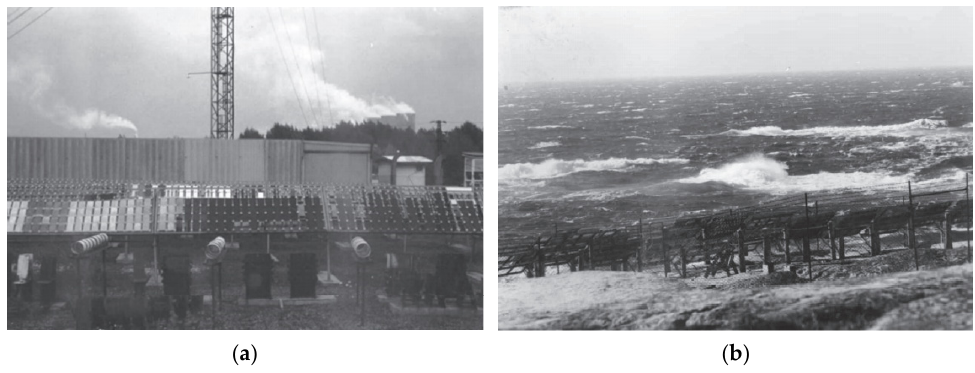
Figure 4. Atmospheric exposure test. ( a ) Industrial atmosphere. ( b ) Marine atmosphere.